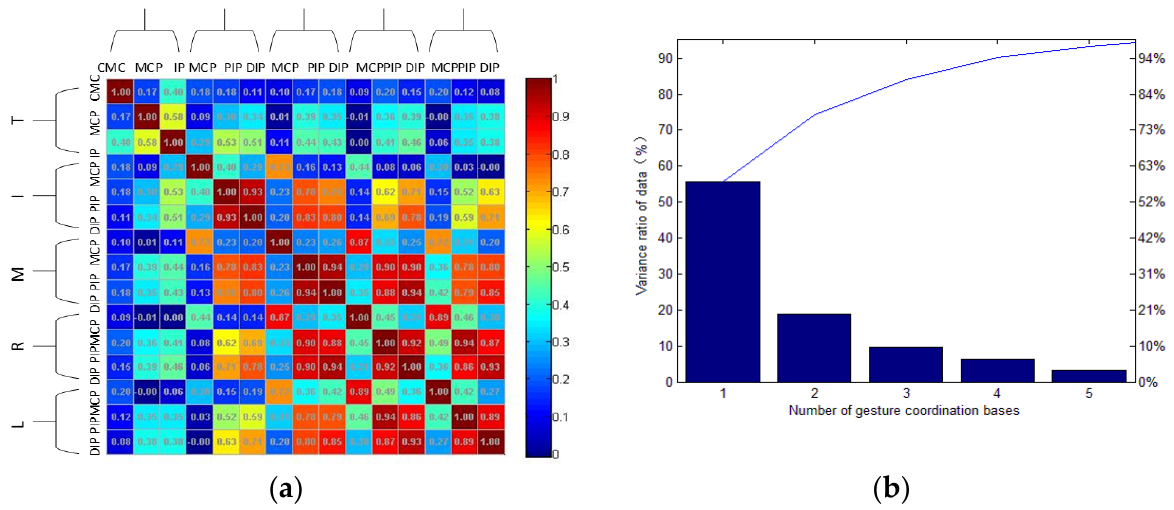
Figure 5. Correlation coefficient diagrams: ( a ) correlation coefficient among joint angles ( 𝑟 ); ( b ) change in variance ratio of hand gesture data.